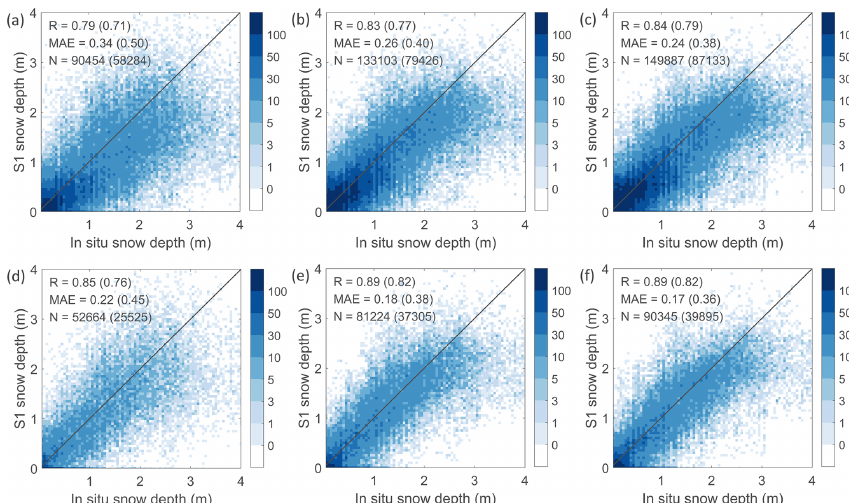
Figure 11. Density plots comparing S1 retrievals of snow depth (m) with corresponding in situ measurements (m) for August through April 2017–2018 and 2018–2019. The comparison is shown for retrievals at (a, d) 100m, (b, e) 500m, and (c, f) 1km resolution, with (a–c) excluding wet snow masking and (d–f) including wet snow masking. The spatio-temporal Pearson correlation R (–), the MAE (m), and number of observations ( N ) are shown at the top left, for scenarios both with and (between brackets) without the inclusion of zero values.